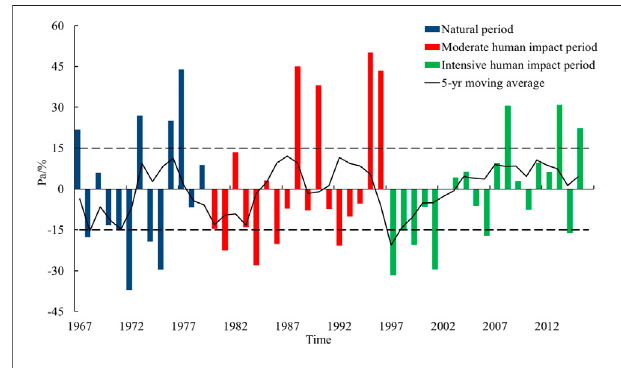
FIGURE 6 | The average seasonal distributions of observed runoff in the Zhulong River catchment during 1967 – 2015.